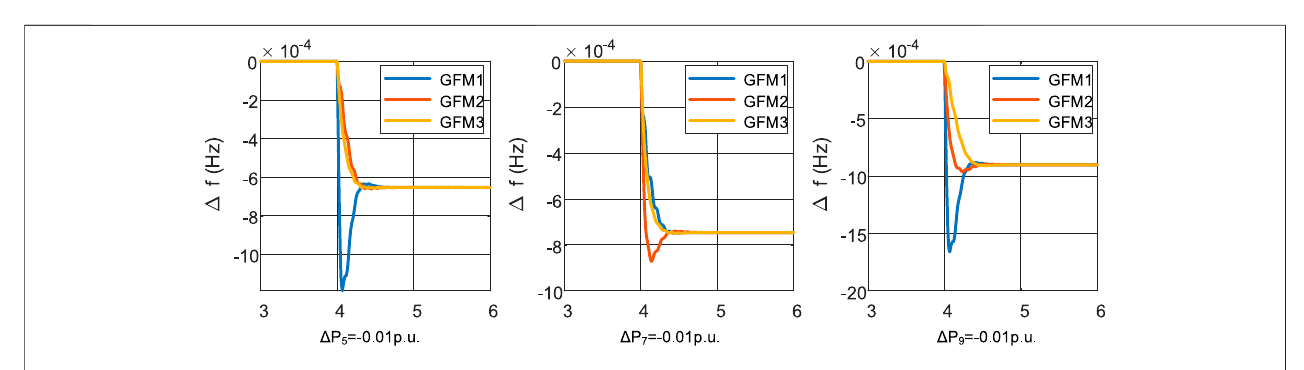
FIGURE 8 | Frequency response with different load